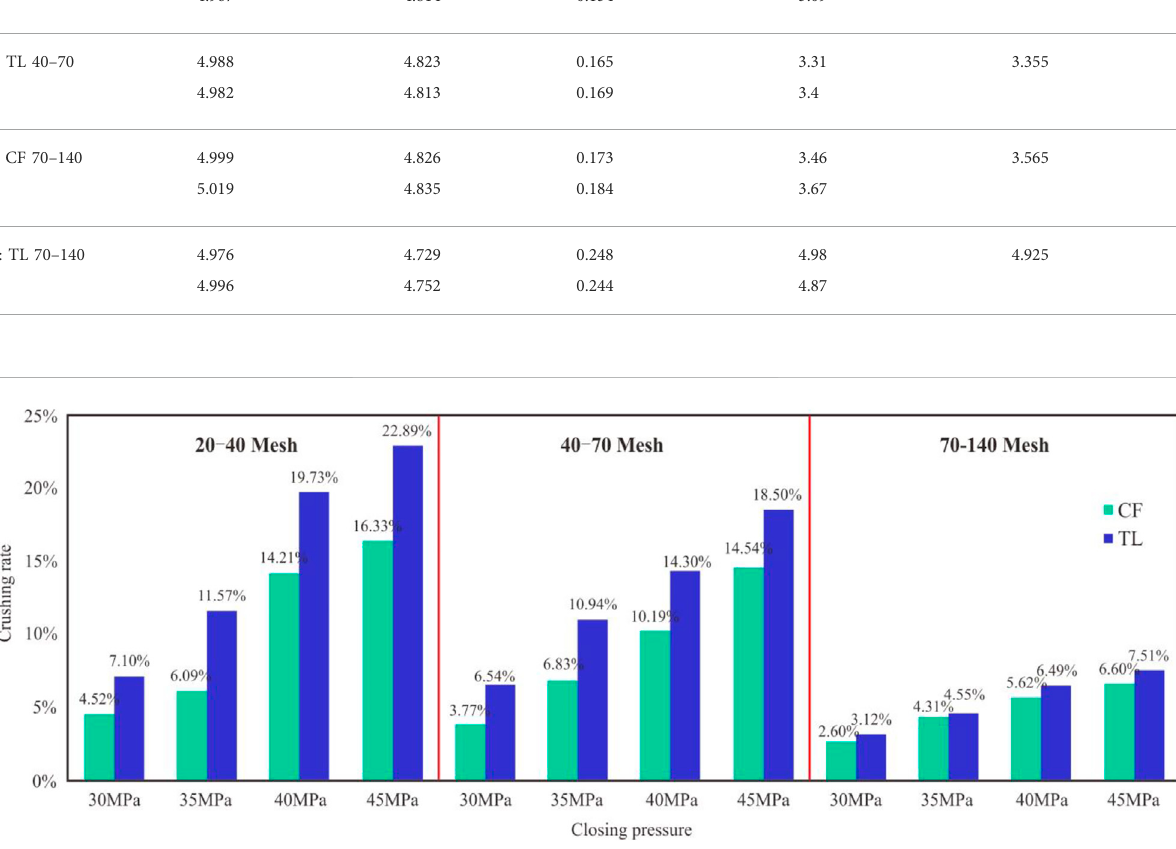
FIGURE 1 Comparison of crushing rate of each proppant with closure